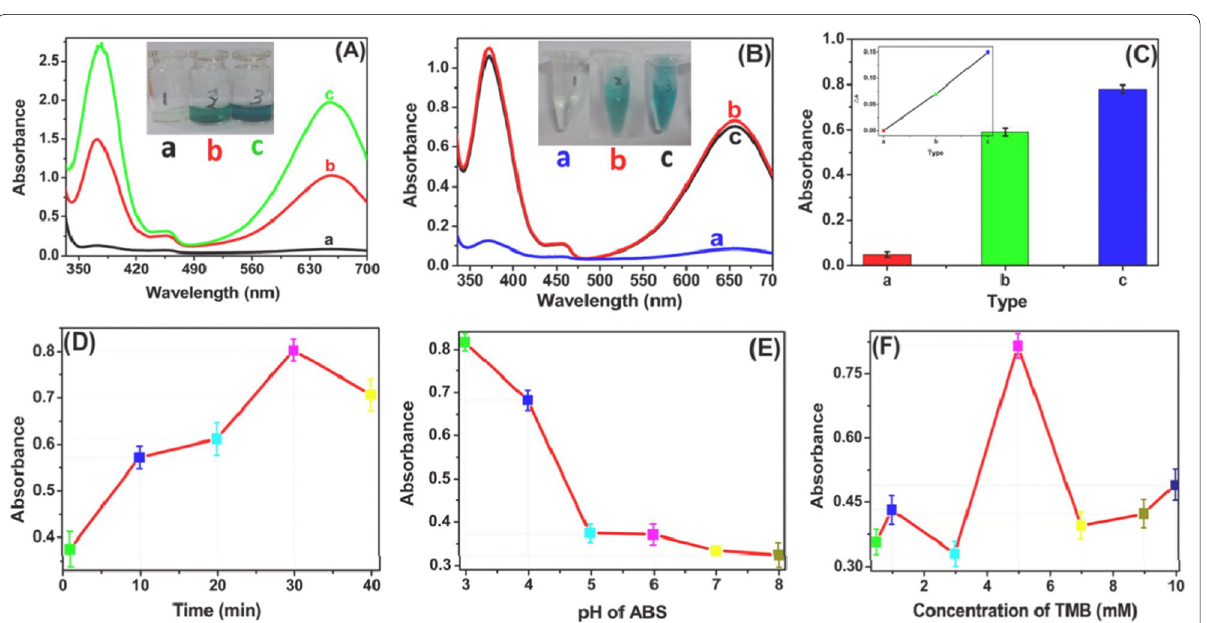
Fig. 14 A The UV–Vis spectrums of (a) TiO 2 the photographs of a, b, c]; B The UV–Vis spectrums of (a) Fe 3 O 4 UV–Vis absorbance of different immunosensors for 0.5 nM CAP (a) anti-CAP-CS-TiO 2 /CAP-BSA/MB, (b) anti-CAP-CS-AgI/CAP-BSA/MB, and (c) anti-CAP-CS-AgI/TiO 2 /CAP-BSA/MB [the inset is ΔA of a, b, c for 0.5 nM CAP]; The effect of D incubation time of antigen–antibody, E pH of ABS, and F concentration of TMB. Adapted from Ref. [48] with permission. Copyright (2017) Biosensors and